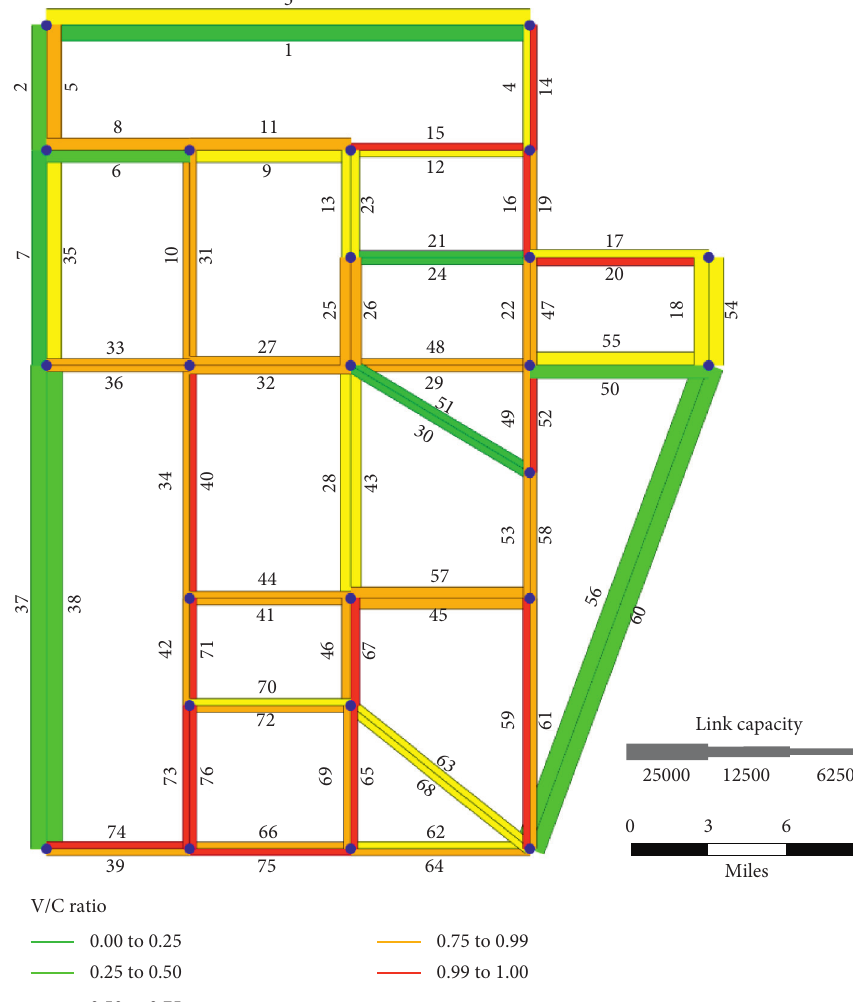
Figure 6: Link utilization pattern of maximum flow with limited parking space and adjusted parking pricing strategy.